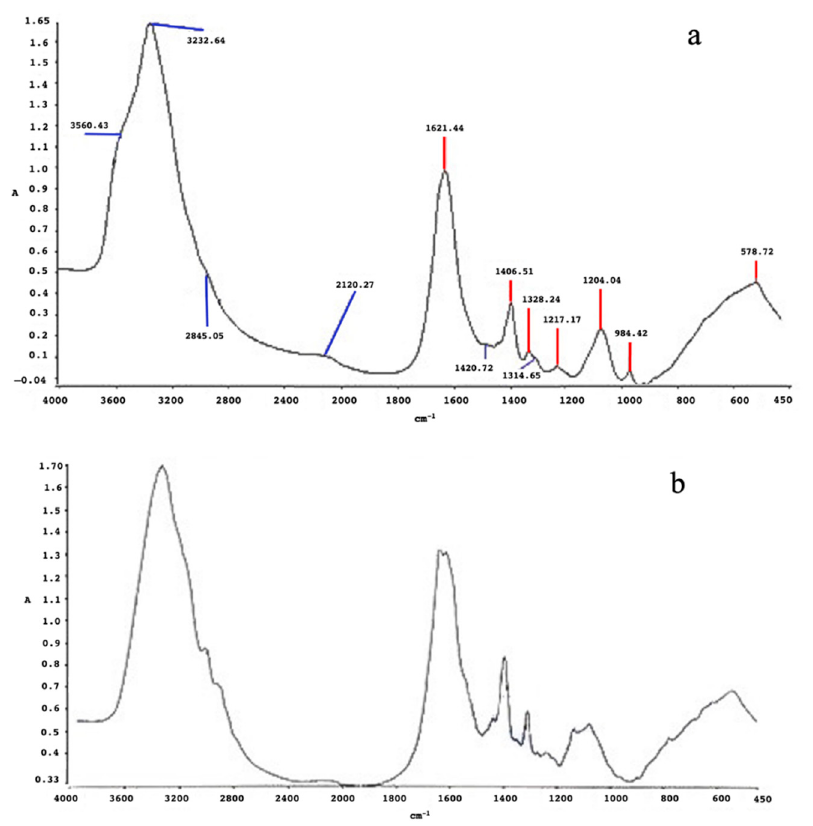
Figure 15. FT-IR spectra of SeNPs produced by 5AG in minimal medium B (panel ( a )) and in minimal medium C (panel ( b )).